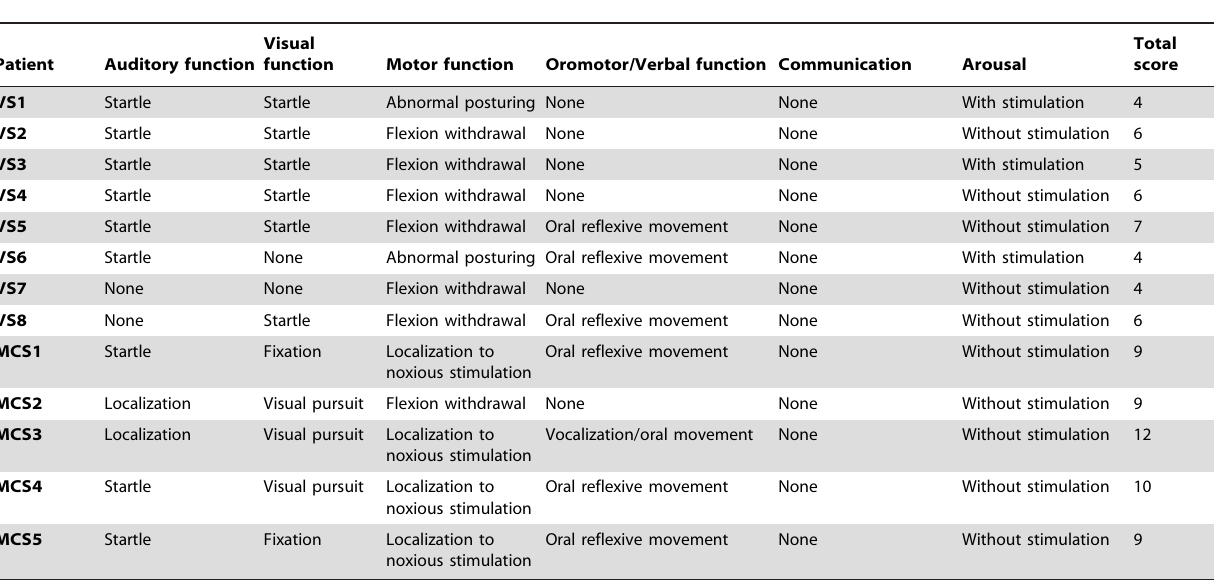
Table 2. Coma Recovery Scale-R, subscales and total scores for all patients.